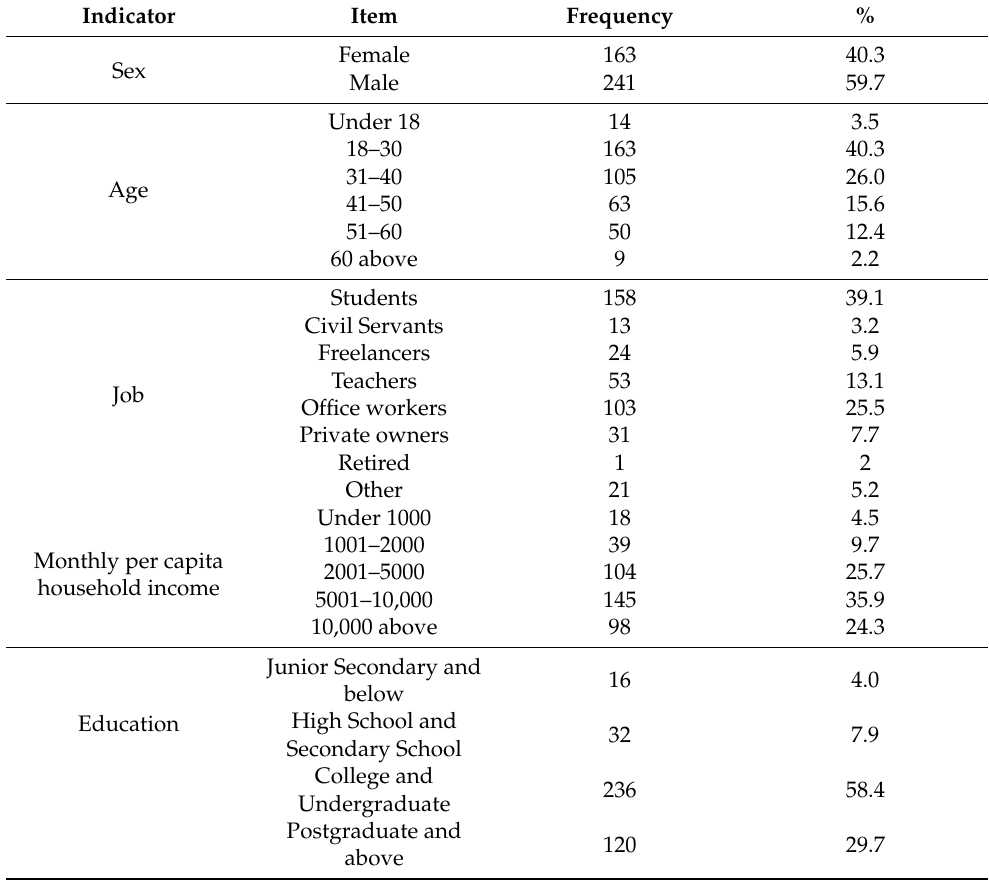
Table 1. Descriptive statistical